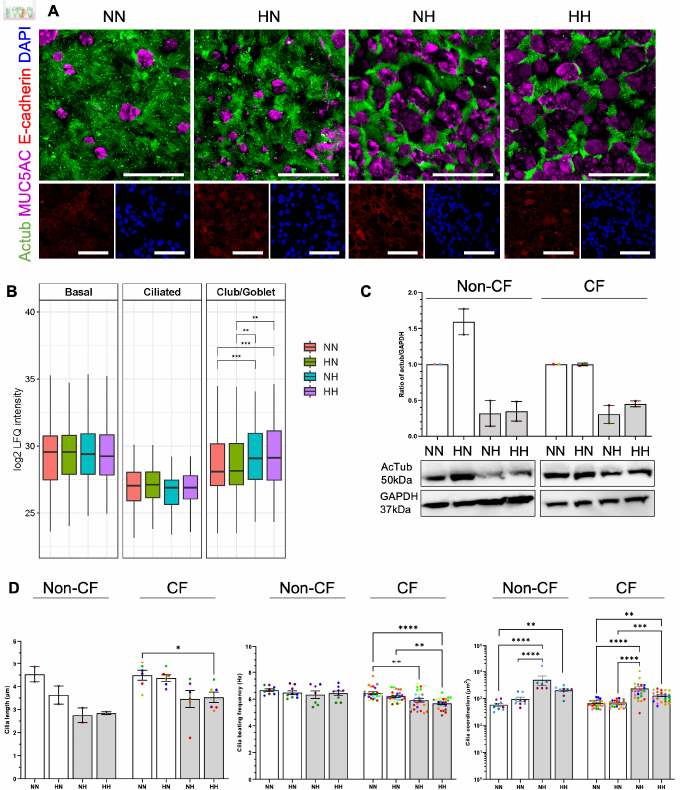
Figure 5. Effect of chronic hypoxia on the epithelial phenotype and cilia function in differentiated human nasal epithelial cells (hNECs). ( A ) Representative immunofluorescence staining of acetylated tubulin (green), MUC5AC (magenta) and E-cadherin (red). 63x/1.4 oil immersion objective. Scale bars = 50 µm. ( B ) Boxplots depicting the variation of log LFQ intensity in proteins found in di ff erent cell types compared across the di ff erent oxygen levels. Boxplots extend from fi rst quartile to the third quartile, with middle line indicating the median. Upper and lower whiskers extend to the largest and smallest values within 1.5 times the interquartile range. Statistical signi fi cance of the di ff erence in median log LFQ intensity across oxygen levels is performed using Wilcoxon Rank Sum test with Benjamini–Hochberg correction for p -value. * adjusted p -value < 0.05, ** adjusted p -value < 0.01, *** adjusted p -value < 0.001, **** adjusted p -value < 0.0001. Data were derived from 3 non-CF and 8 CF participants. ( C ) Western blo tt ing of cilia marker acetylated tubulin from 2 non-CF and 2 CF participants. ( D ) Cilia length (left), cilia beating frequency (middle) and coordination (right) of mature ALI cultures di ff erentiated at normoxia and hypoxia for 21–25 days. For cilia length, each colored circle represents an individual participant. For cilia beating frequency and coordination, each individual participant’s data is presented with a di ff erent color. Three independent transwells were analyzed per participant. Data are presented as bar plots with mean ± standard error of the mean (SEM). One-way ANOVA was used to determine statistical signi fi cance. * p < 0.05, ** p < 0.01, *** p < 0.001, and **** p < 0.0001.